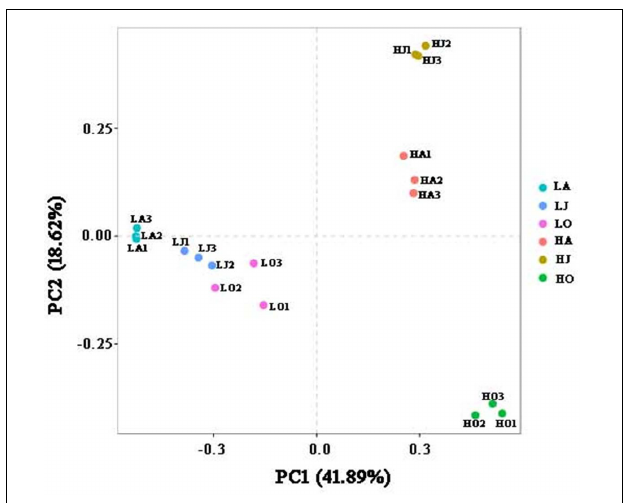
FIGURE 1 | Principal component analysis (PCA) displaying beta-diversity of microbial diversity between samples. PCA was calculated using weighted Unifrac distance. A total of 41.89 and 18.62% of the variations in the bacterial communities could be explained by the first and second principal components,